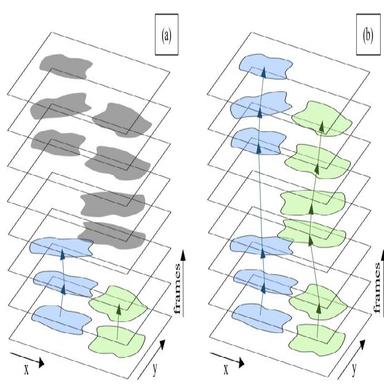
A schematic illustrating the basic principle of the proposed method for improved tracking, (a) traditional approach in which IoU tracks are discontinued due to missing detections, (b) proposed method allow continuity by employing a record of spacial locations of missing detections for appropriate number of frames.